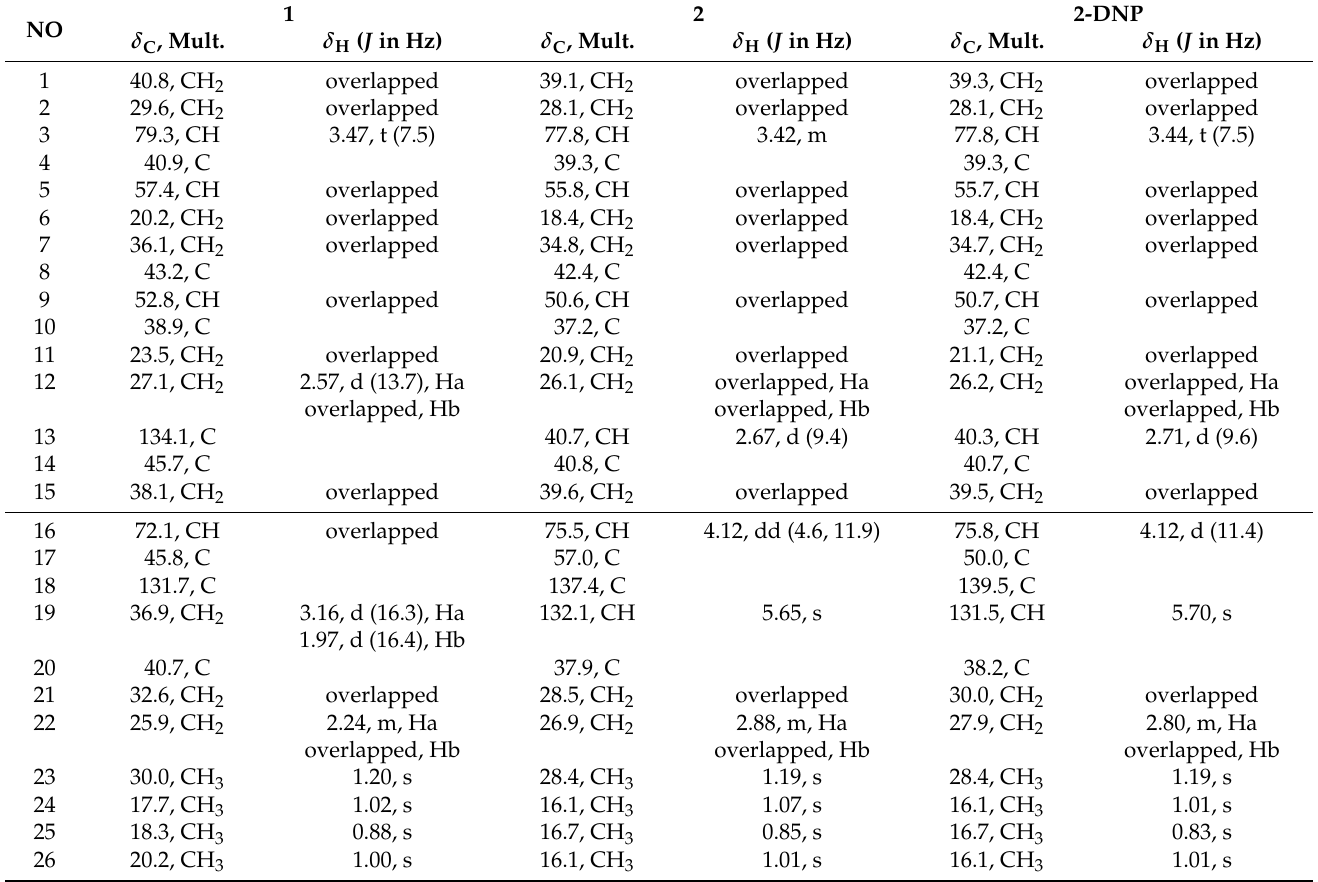
Table 1. NMR data of compounds 1 , 2 , and 2-DNP in pyridine (400 MHz for 1 H; 100 MHz for 13